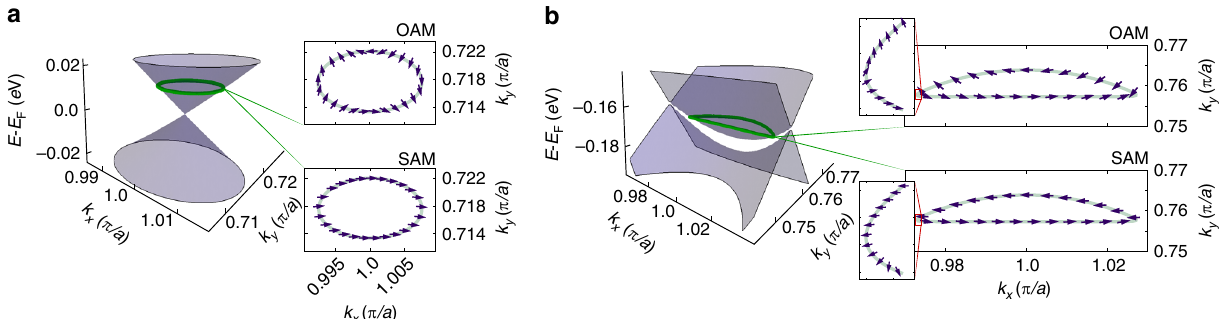
Fig. 4 Weyl-like points in the surface band structure of NbGeSb. a Band dispersions around the like-spin protected crossing (#4 from Fig. 3c) as calculated from our tight-binding model. Orbital (top) and spin (bottom) angular momenta extracted around the indicated contour are shown as insets; the arrows represent the direction of the angular momenta. The OAM shows a characteristic winding around the contour with winding number (cid:3) 1, unlike for the spin which exhibits only slight canting around the contour. b Equivalent calculations around the weakly gapped crossing (#3 in Fig. 3c). Now both the orbital (top inset) and spin (bottom inset) angular momenta exhibit winding around the indicated contour, with winding numbers (cid:3) 1 and þ 1, respectively, but the majority of the winding is restricted in close proximity to the mirror line, as can be seen in the magni fi